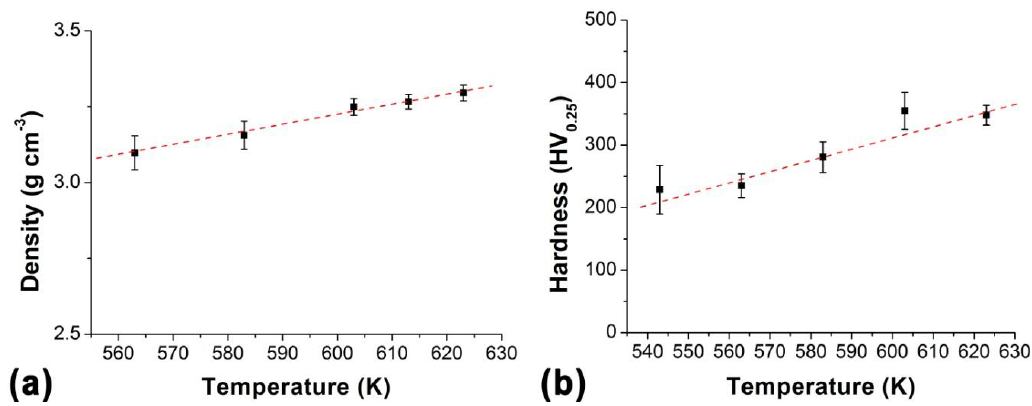
Figure 9. ( a ) Density and ( b ) micro-hardness of amorphous Al 82 La 10 Fe 4 Ni 4 samples at various sintering temperatures.